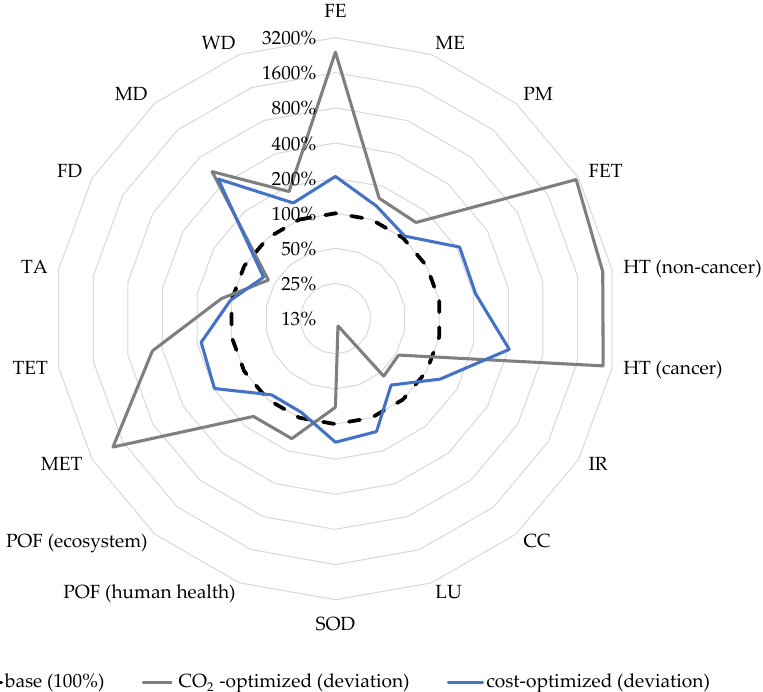
Figure 3. Percentage deviation of the two target scenarios from the base scenario. The base scenario is used as the reference scenario in the presentation and the adverse effect is defined as 100% in each category. For the target scenarios, the changes in the environmental impact categories are each calculated referring to the reference scenario and presented as percentage deviations from the actual scenario. Values greater than 100% represent a greater environmental impact, smaller values a lesser environmental impact. For better representation, the axis is logarithmic. Abbreviations: FE = fresh- water eutrophication, ME = marine eutrophication, PM = particulate matter formation, FET = fresh water ecotoxicity, HT = human toxicity, IR = ionizing radiation, CC = climate change, LU = land use, SOD = stratospheric ozone depletion, POF = photochemical ozone formation, MET = marine ecotox- icity, TET = terrestrial ecotoxicity, TA = terrestrial acidification, FD = fossil depletion, MD = metal depletion, and WD = water depletion.